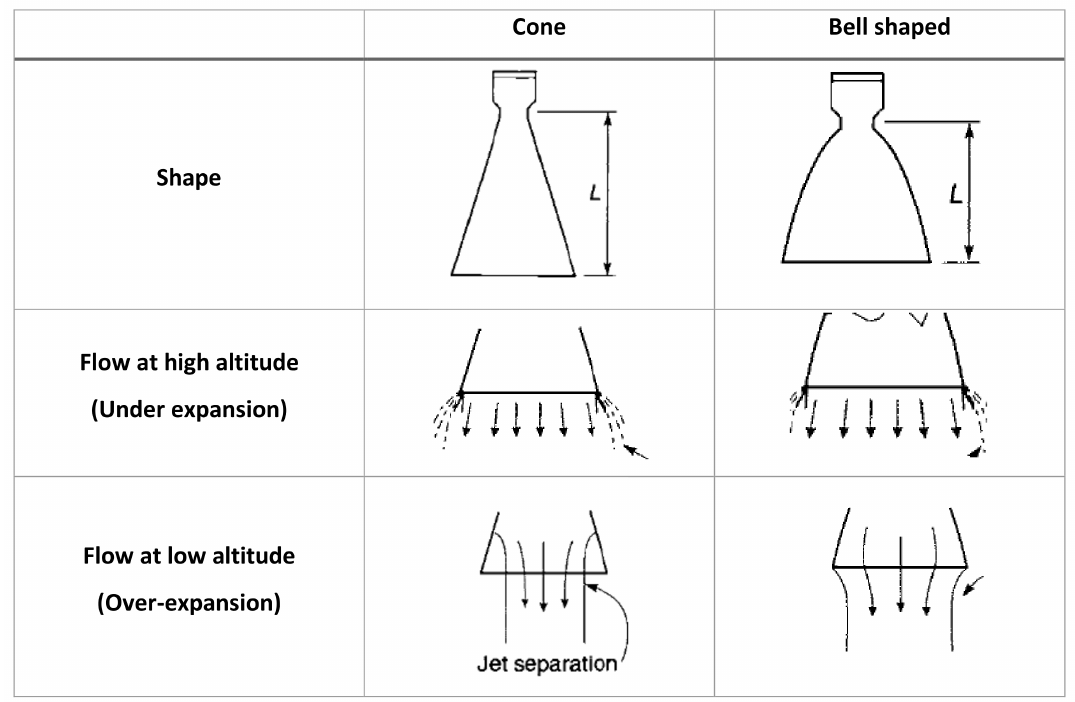
Figure 7. Nozzle performance at different altitudes.